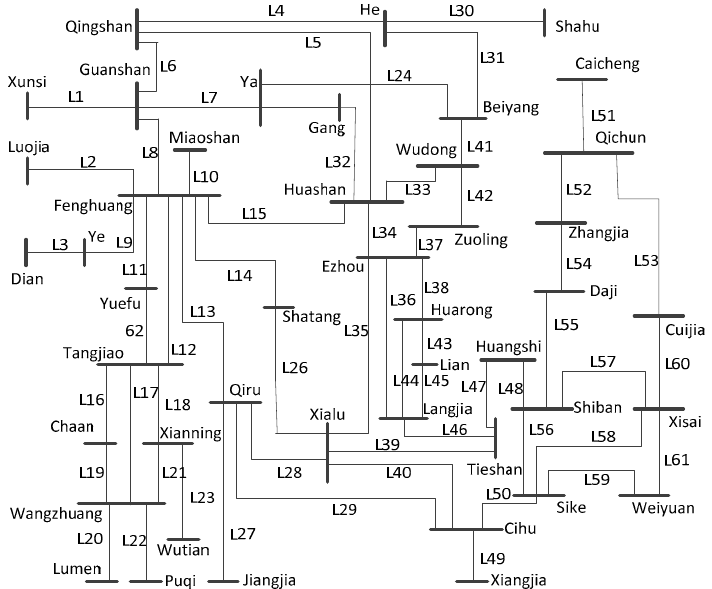
Figure A2. The 220 kV grid communication system in the eastern region of Hubei province, China, to verify the applicability of the partition strategy proposed in this article under larger system conditions.